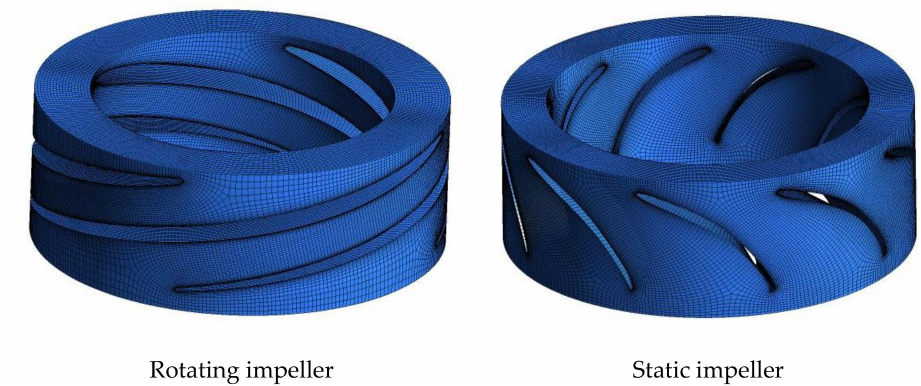
Figure 8. Hexahedral meshes of the pressurized unit.